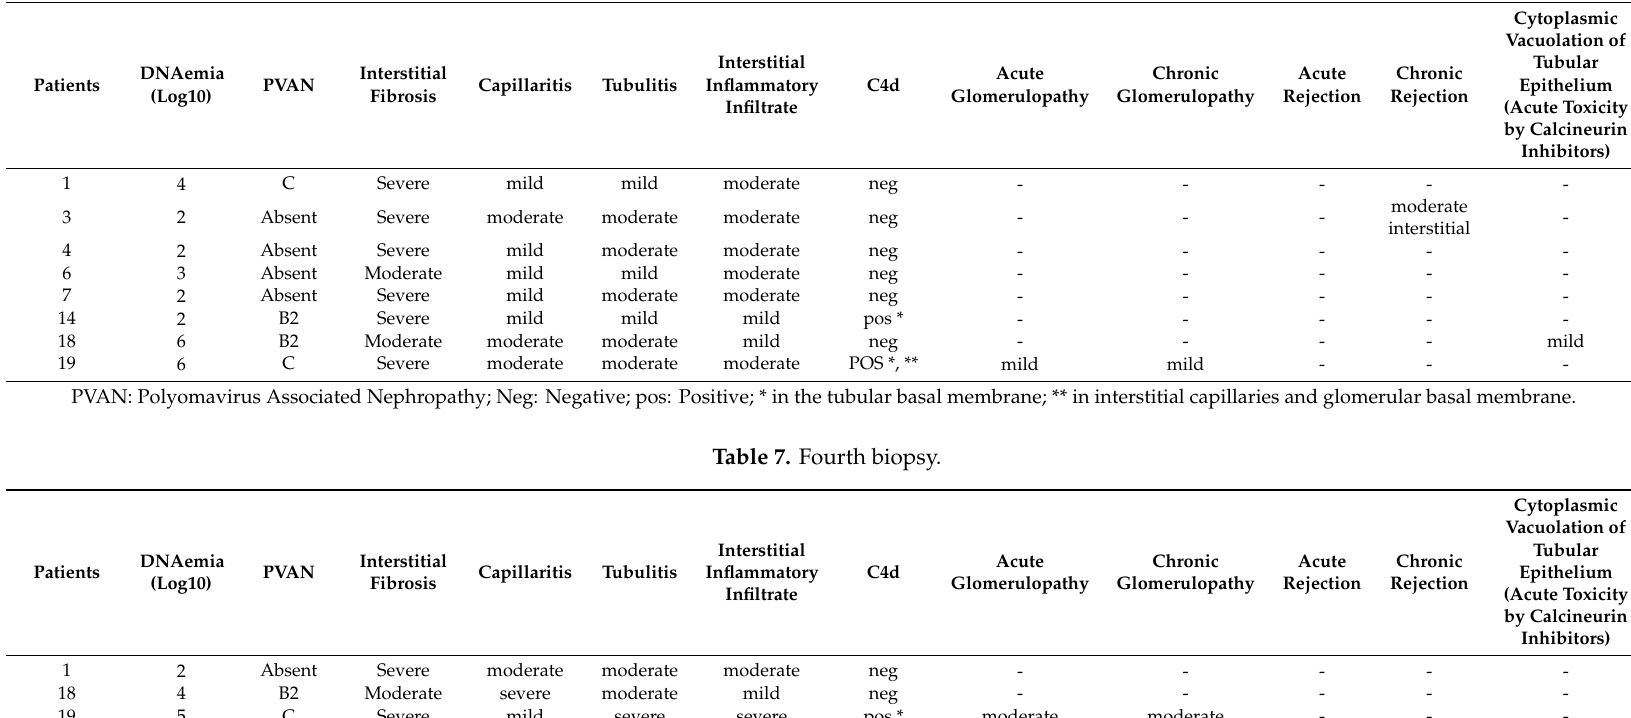
Table 6. Third biopsy.